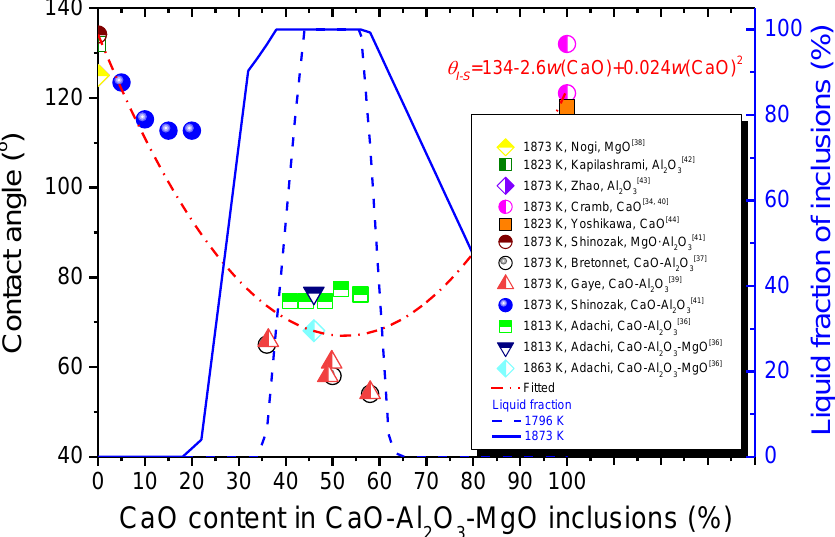
Figure 11. Contact angle between CaO-Al 2 O 3 -MgO inclusions and the molten steel.